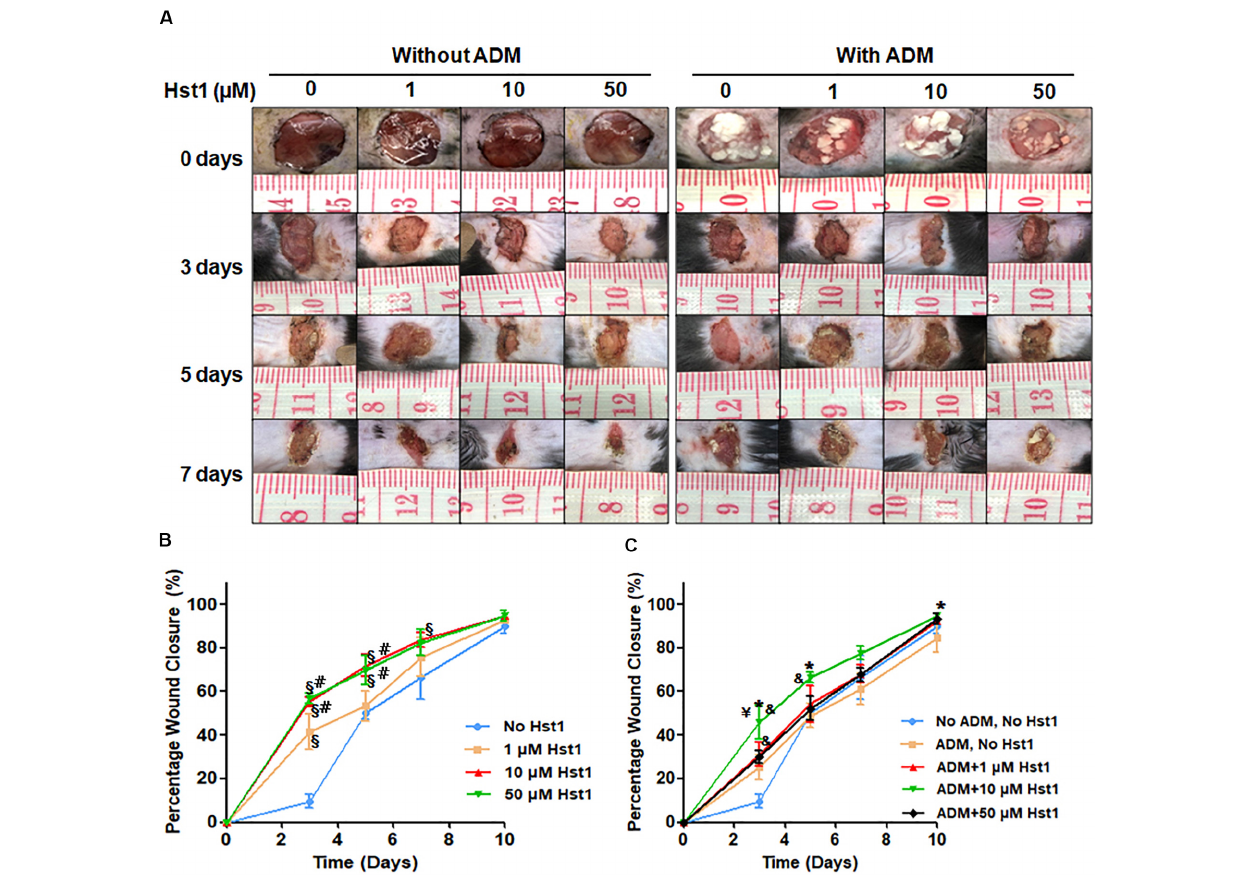
FIGURE 1 | 3, 5, 7, and 10 days post-surgery, the dynamic changes of wound area in different groups after treatment. (A) Representative images of acute wounds showed that the wound area treated by 10 µ M Hst1 was significantly smaller than the other groups; (B) The temporal changes of wound healing percentage (%) in each treatment group. On days 3, 5, and 10, the healing percentage of the wounds treated by 10 µ M Hst1 was significantly higher than the control; (C) ADM + 10 µ M Hst1 was associated with significantly higher healing percentage than the ADM and the control on days 3 and 5. Data were presented as mean ± SD. §: the 1, 10, 50 µ M Hst1 group vs the control group; #: the 10, 50 µ M Hst1 group vs the 1 µ M Hst1 group; &: the 1, 10, 50 µ M Hst1 + ADM group vs the control group; *: the 10 µ M Hst1 + ADM group vs the ADM group. –Y: the 10 µ M Hst1 + ADM group vs the 50 µ M Hst1 + ADM group ( P <